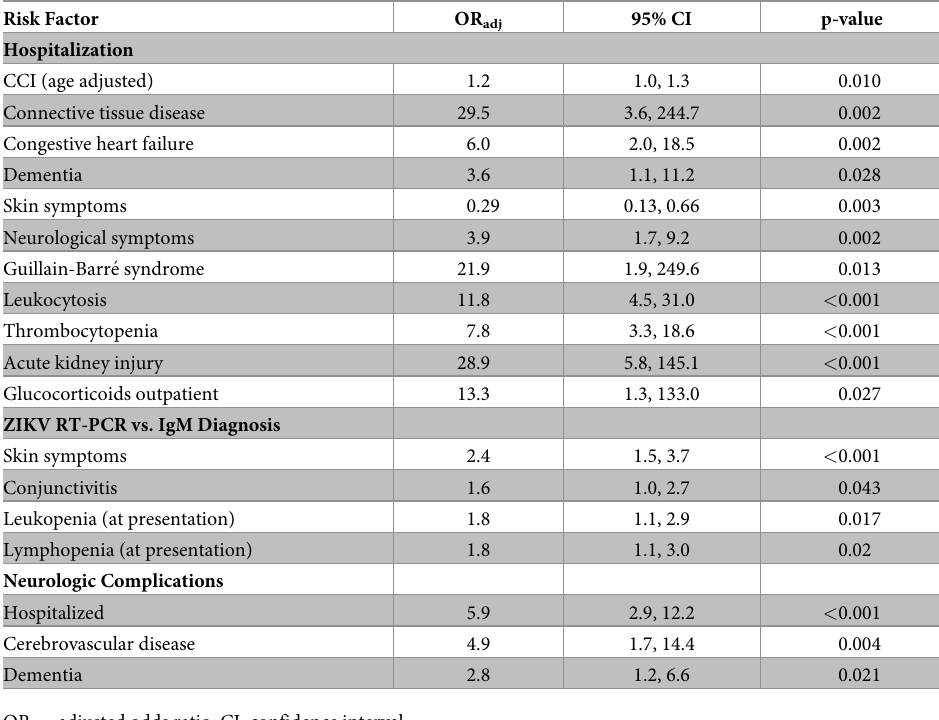
neurologic complications as summarized in Table 1. Five patients had cerebrospinal fluid (CSF) tested for ZIKV, all of whom had at least one of the identified neurologic complications. One patient with altered mental status, meningitis and viral encephalitis was positive for ZIKV by RT-PCR in CSF and serum. CSF findings for this patient were consistent with a viral etiol- ogy, demonstrating mild pleocytosis (WBC 12/cm 3 , 88% polymorphonuclear leukocytes, 12% lymphocytes) and normal CSF protein level (30.2 mg/dL). As shown in Table 4, neurologic Table 4. Adjusted associations between comorbidities, clinical findings, laboratory findings, and medication use and 1) hospitalization 2) neurologic complications 3) ZIKV RT-PCR